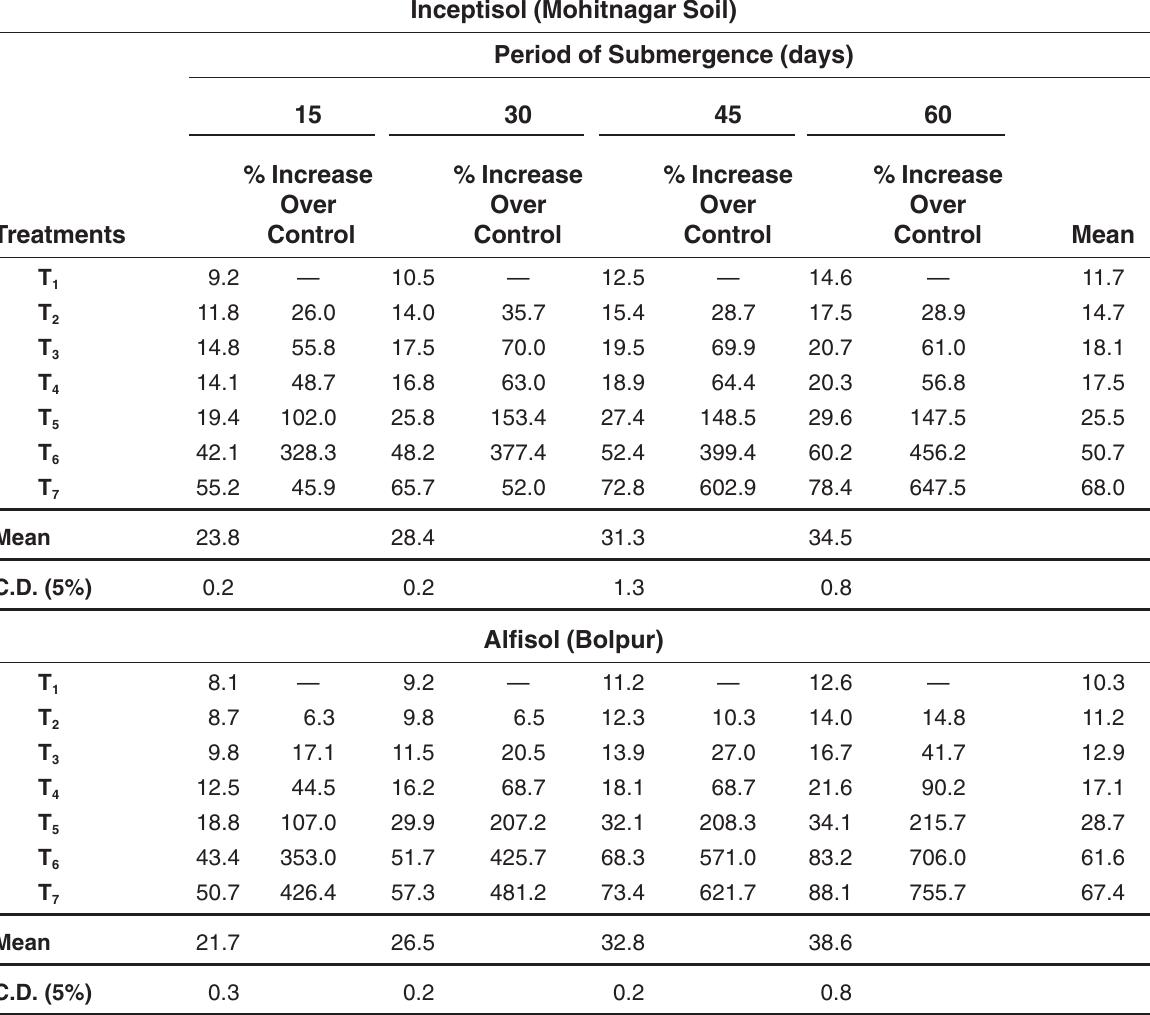
Effect of Potato Skin, Wheat Straw, and Groundnut